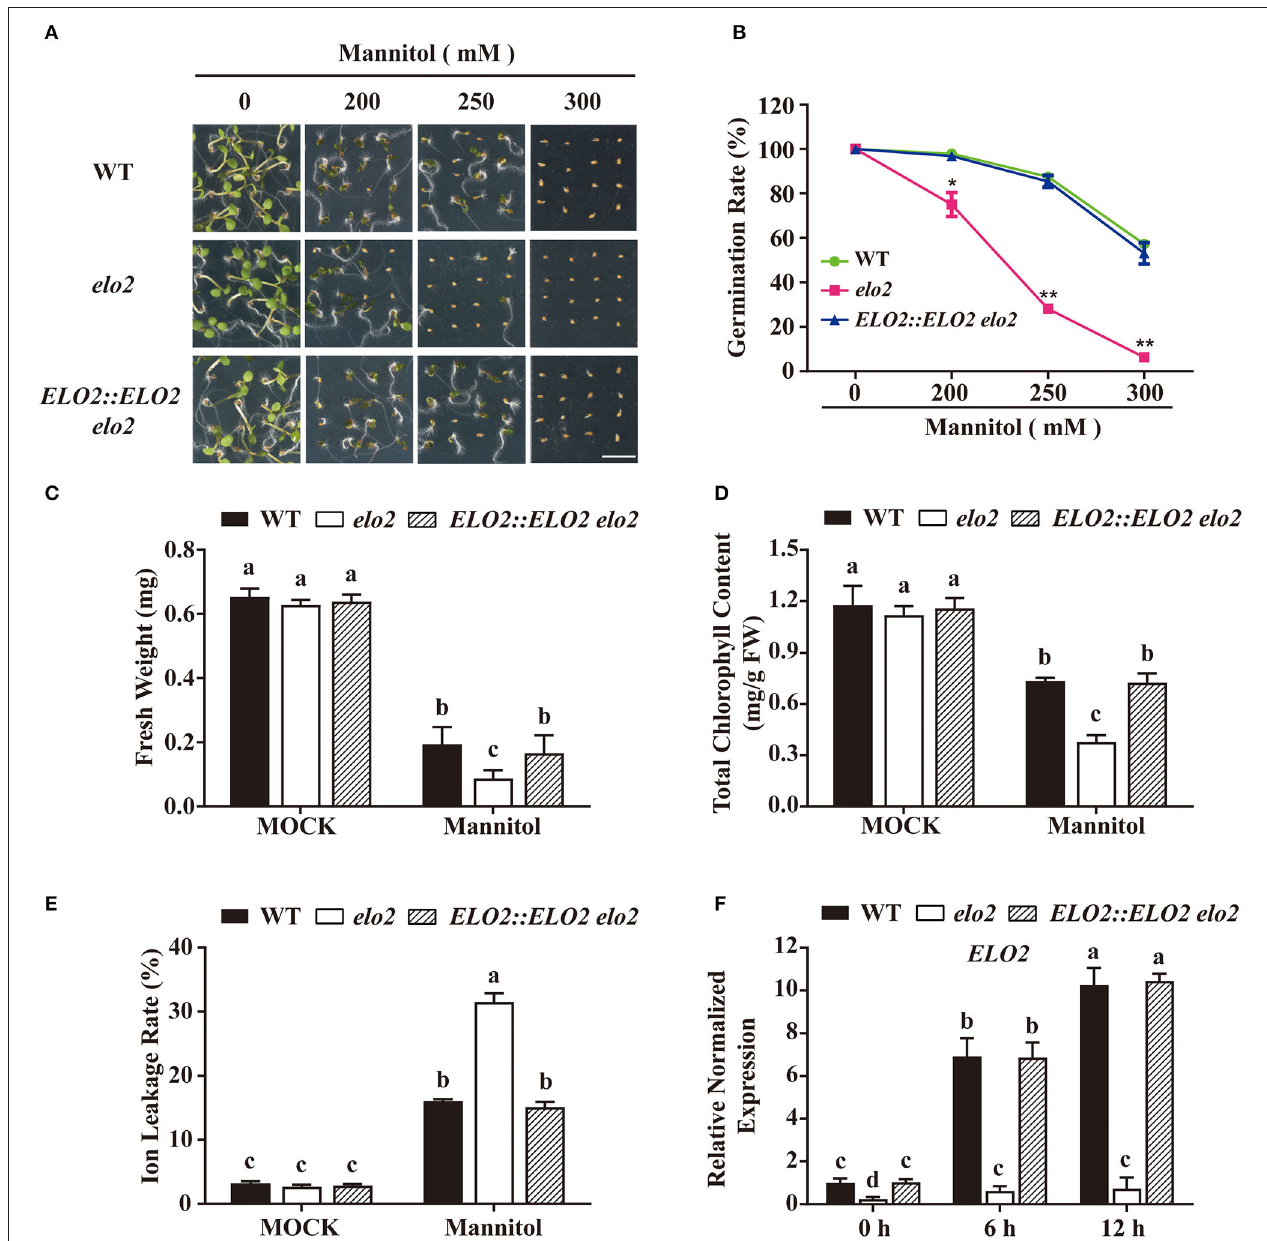
FIGURE 1 | Arabidopsis ELO2 acts in plant osmotic stress response. (A,B) Phenotypes (A) and germination rate (B) of WT, elo2 , and ELO2::ELO2 elo2 plants under the treatment of 200, 250, or 300mM mannitol for 5 days Scale bars = 0.5cm. (C) Fresh weight of WT, elo2 , and ELO2::ELO2 elo2 plants under the treatment of 250mM mannitol for 5 days. (D,E) Total chlorophyll content (D) and ion leakage rate (E) of 5-day-old WT, elo2 , and ELO2::ELO2 elo2 seedlings under the treatment of 250mM mannitol for 12h. FW: fresh weight. (F) Relative normalized expression of ELO2 in 5-day-old WT, elo2 , and ELO2::ELO2 elo2 seedlings under the treatment